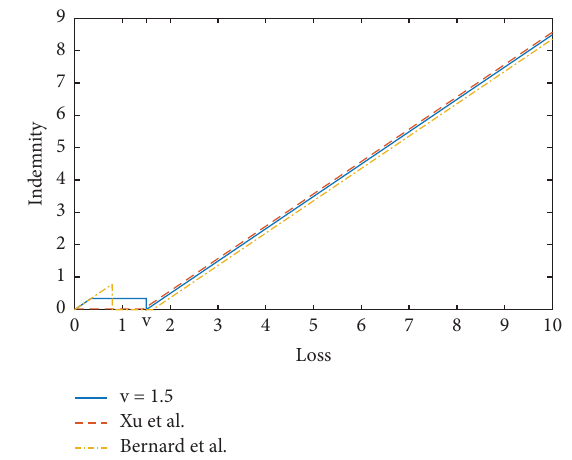
Figure 2: Optimal indemnities in our study and those of Xu et al. [3] and Bernard et al. [16].